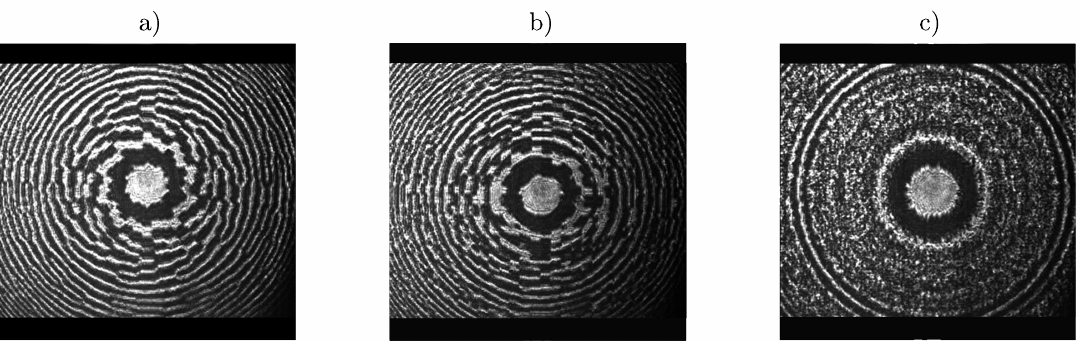
Figure 10. Image of the experimental achromatic lenses recorded in material’s plane using CCD camera: ( a ) 30 sectors in three zones; ( b ) random multiplexing 8 × 8 pixels and ( c ) random multiplexing 1 × 1